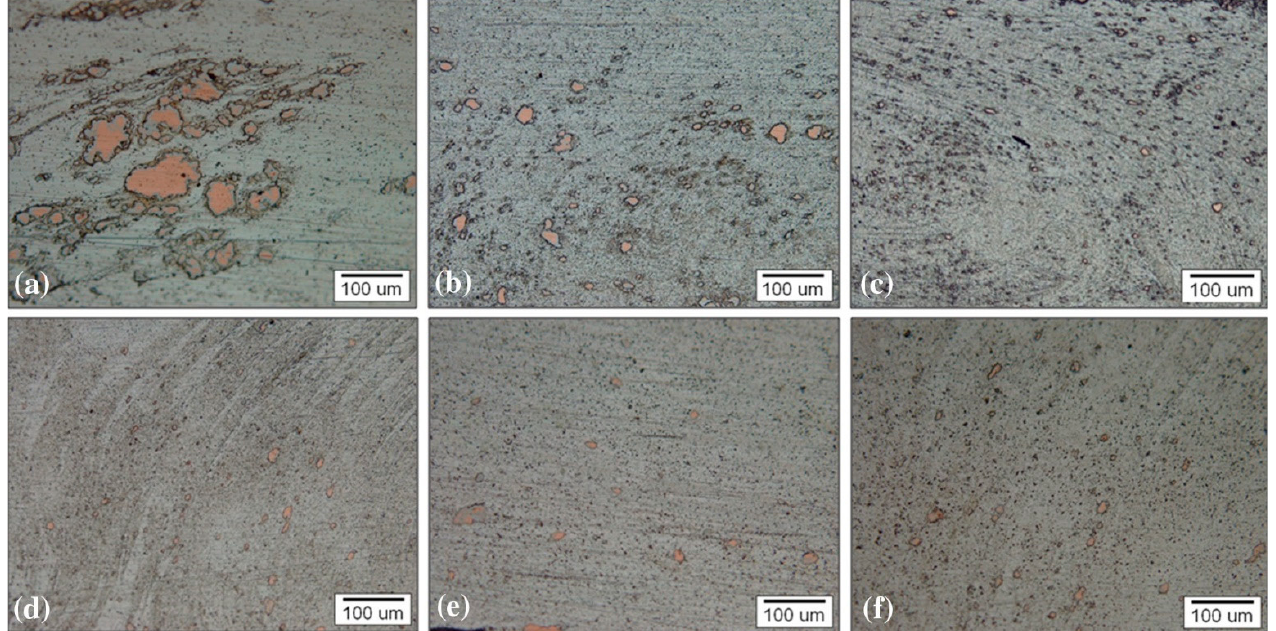
Figure 19. Optical microscope images of the stir zone obtained after two passes of FSW: ( a ) 800 rpm; ( b ) 1000 rpm; ( c ) 1200 rpm using only Cu powder and ( d ) 800 rpm; ( e ) 1000 rpm; ( f ) 1200 rpm using premixed Al-Cu powder (travel speed: 100 mm/min) [165]. Reprinted from: The effect of premixed Al-Cu powder on the stir zone in friction stir welding of AA3003-H18. Journal of Materials Engineering and Performance 24 (2015): 1086–1093, Abnar, B., M. Kazeminezhad, and A. H. Kokabi, Copyright 2015, with permission from Springer Nature.